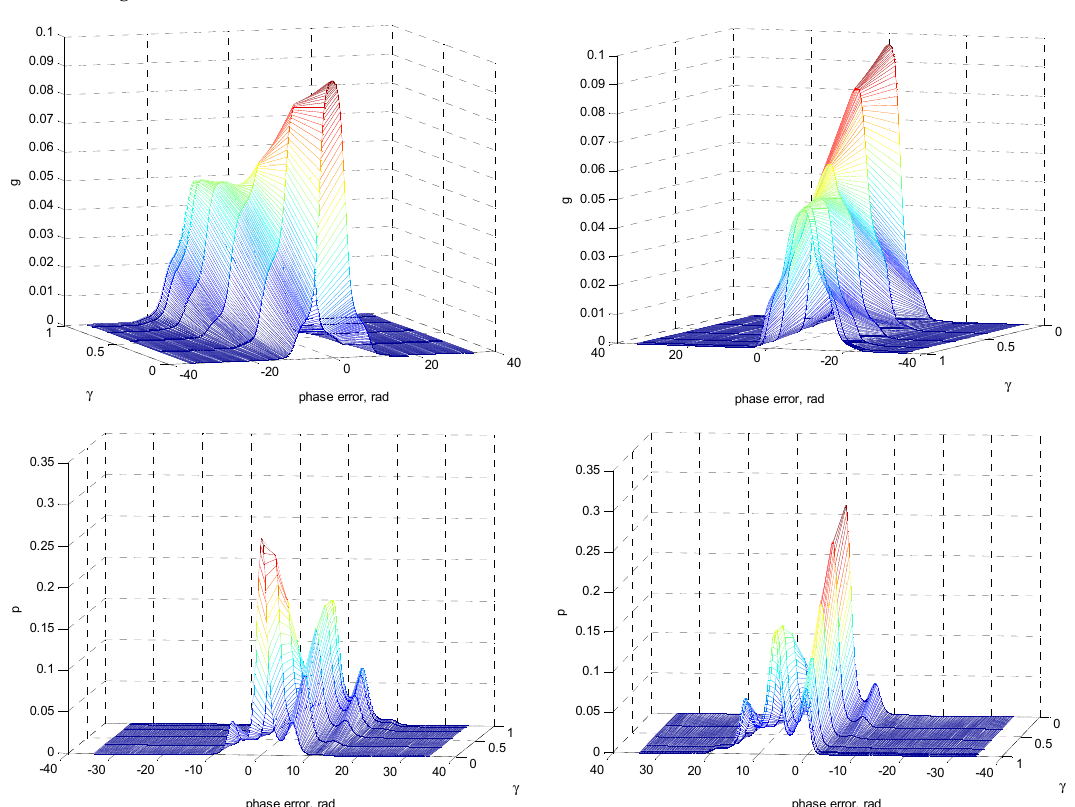
Figure 16. Three-dimensional plots for nonmodulo-2 π g and p , respectively, at τ = 10 for various detuning factors γ when SNR α = 1: front view ( left ) and back view ( right ).